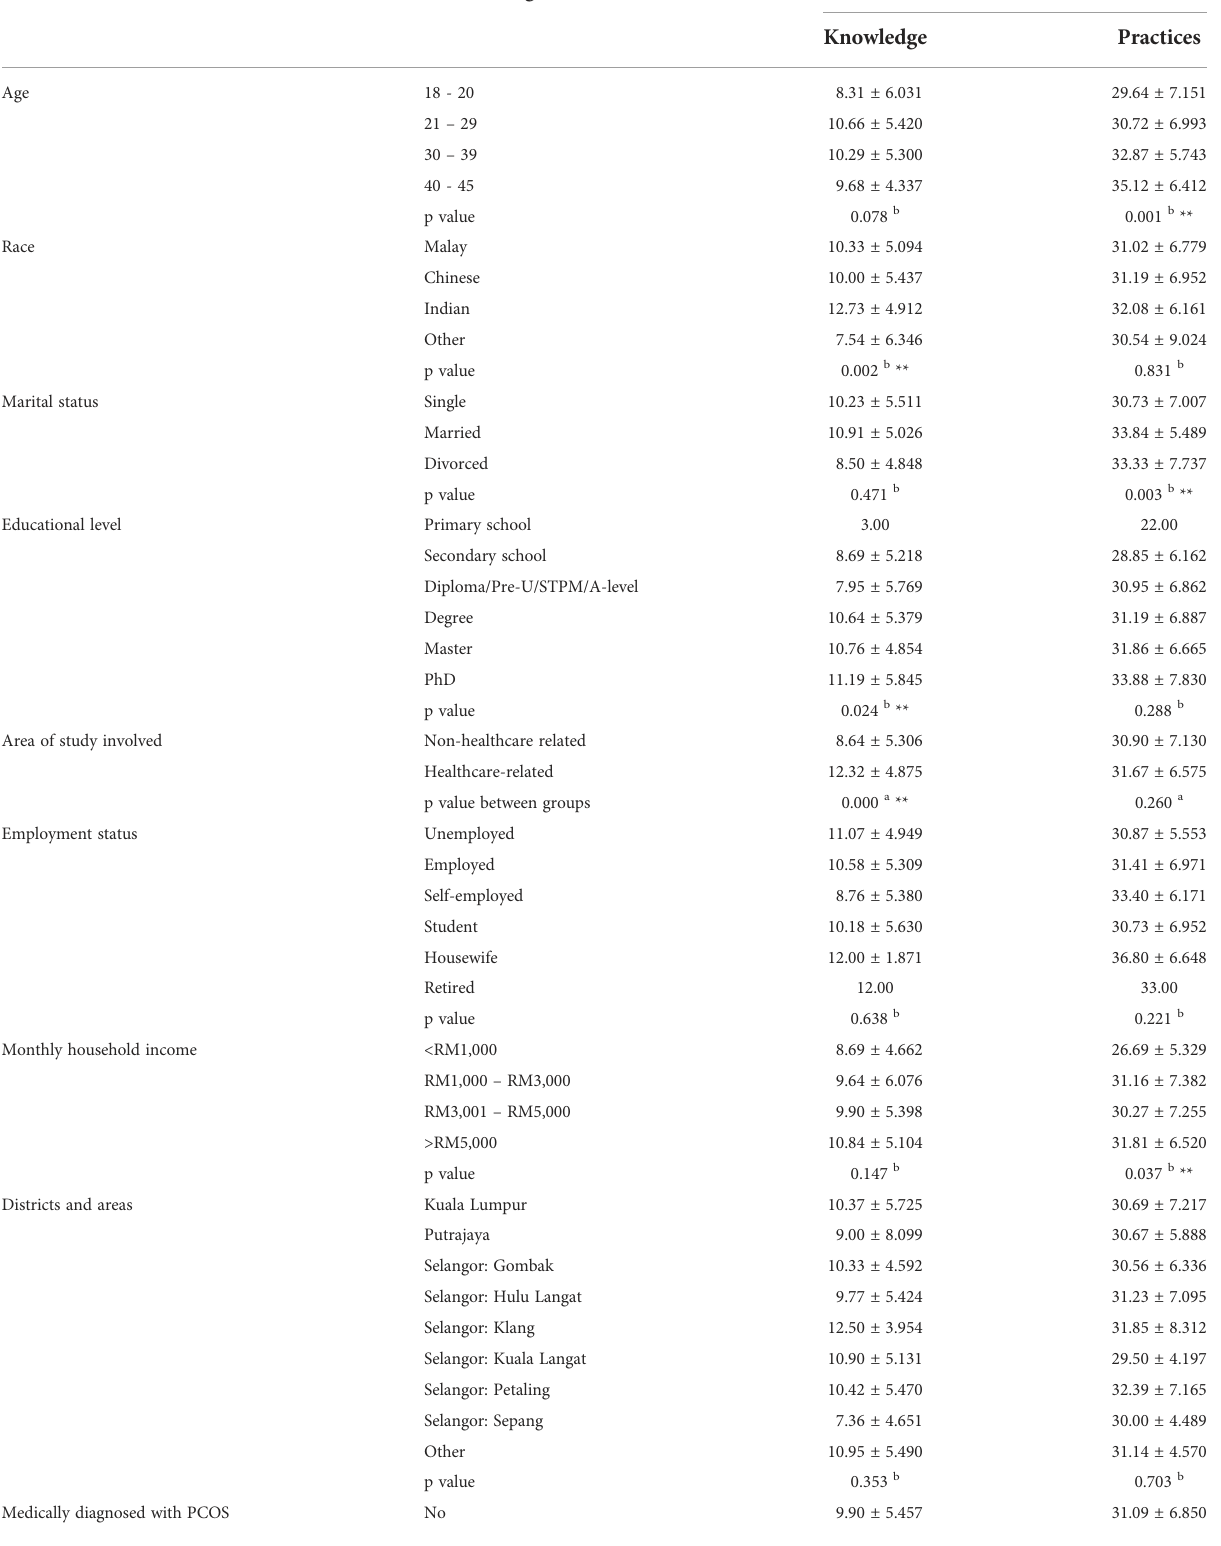
TABLE 1 Summary of knowledge and health-related practice scores with sociodemographic